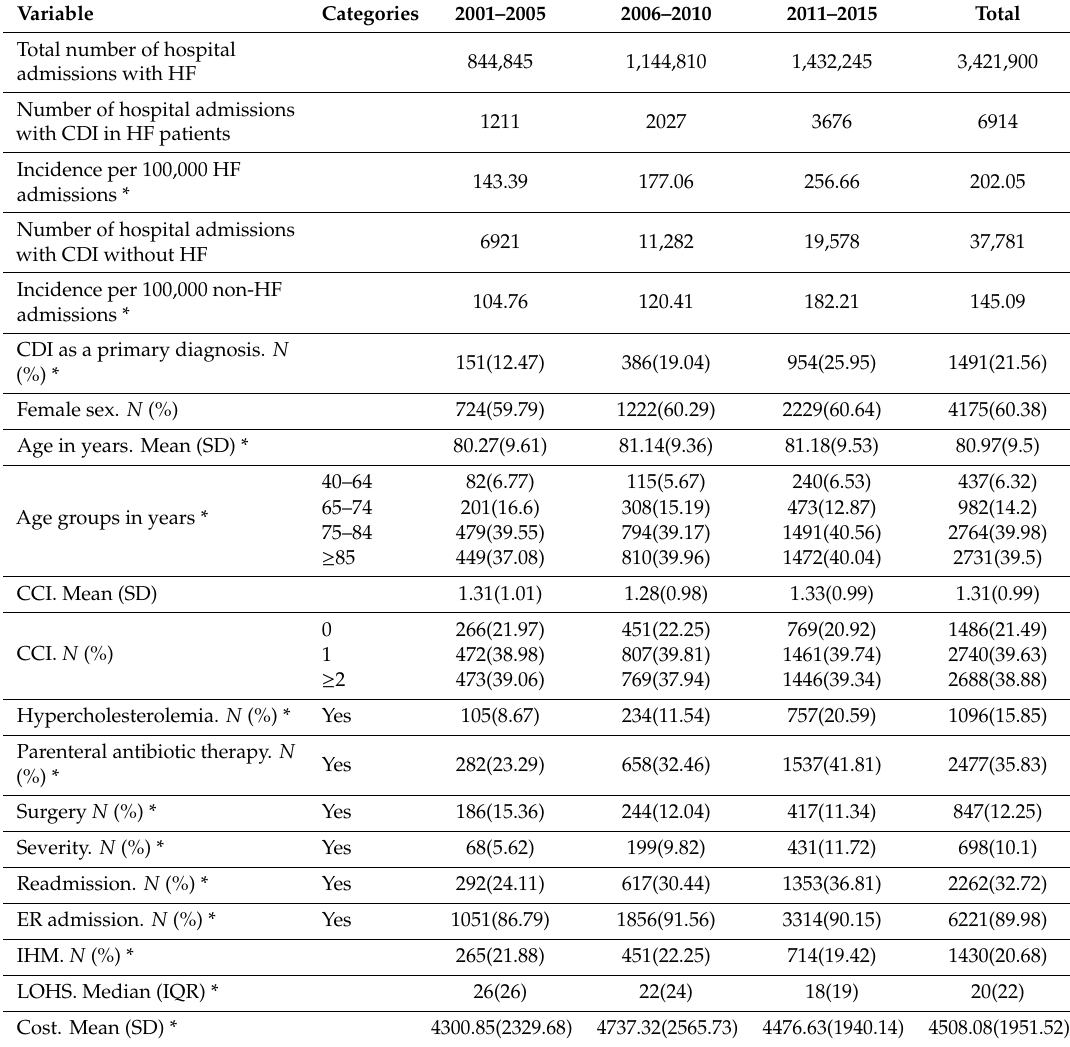
HF—Heart Failure. CDI— Clostridioides di ffi cile infection. CCI—Charlson Comorbidity Index. ER—Emergency room. LOHS—Length of hospital stay. IHM—In-hospital mortality. SD—Standard Deviation. IQR—Interquartile range. * p < 0.05 to assess time trend from 2001 to